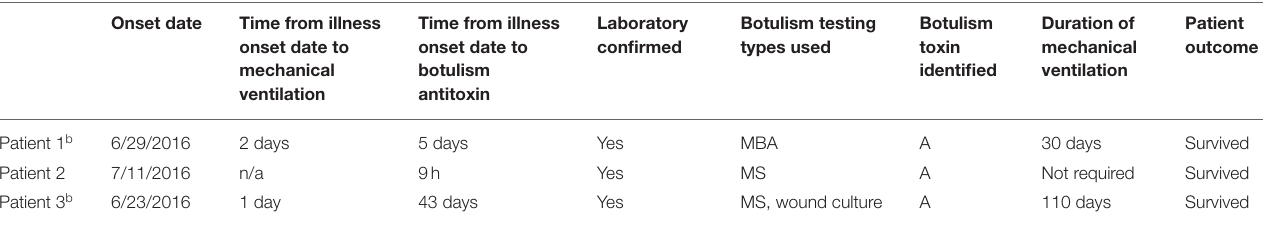
TABLE 2 | Time to botulism antitoxin (BAT) administration, duration of mechanical ventilation, and outcome among wound botulism patients ( N = 3) a